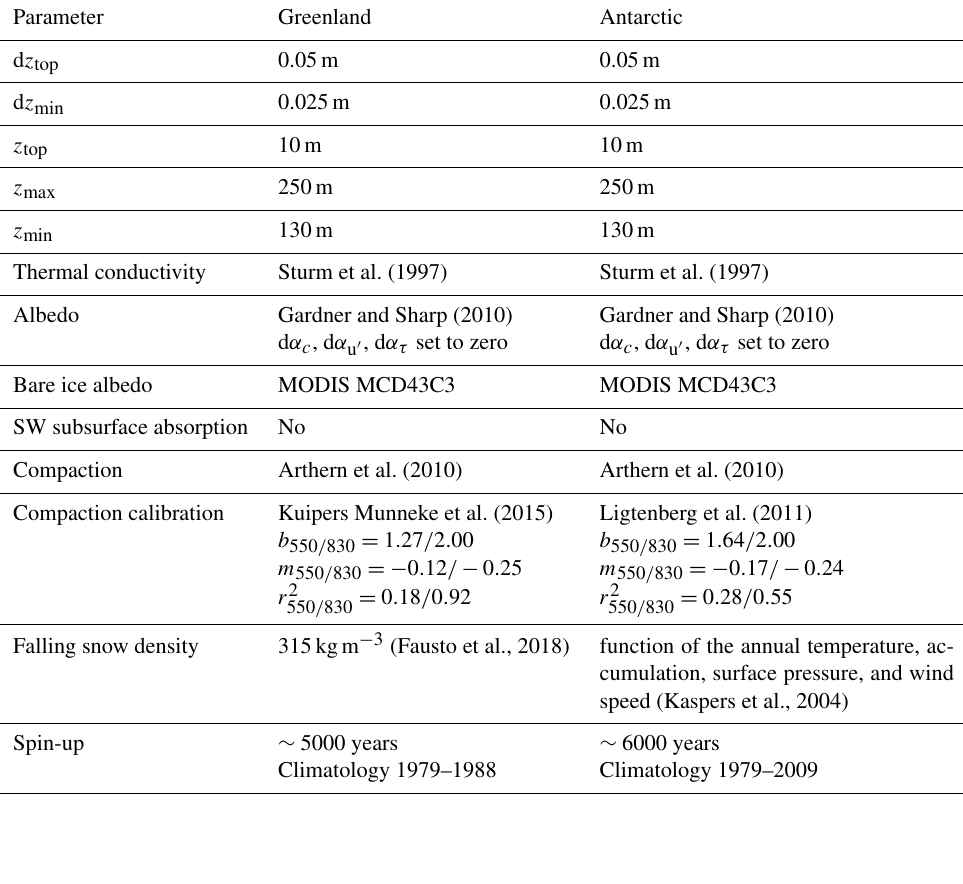
Table 1. GEMB model parameters used in this study.